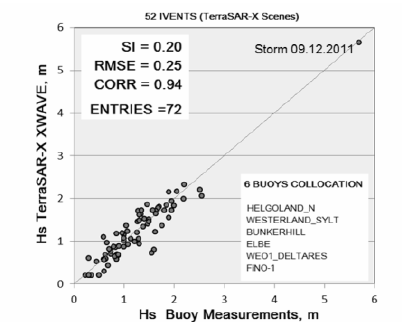
Figure 7. Total comparison of all available data in German Bight 2013-2015 including a storm on 09.12.2011: 46 TerraSAR-X Scenes (overflights/events/days) with 173 Images and 72 buoy collocations (collocation around 20min and up to 5km spatially).